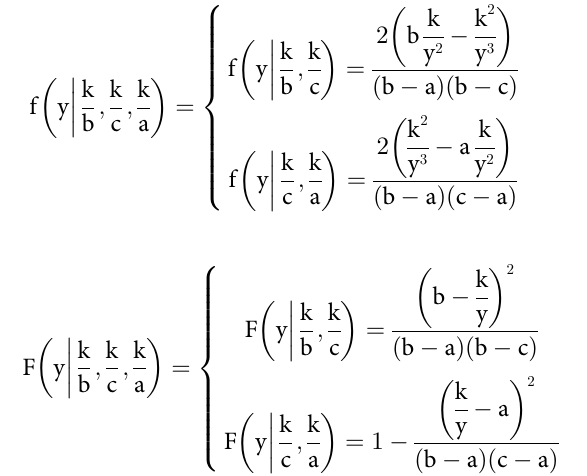
PLOS ONE | DOI:10.1371/journal.pone.0129572 June 10,